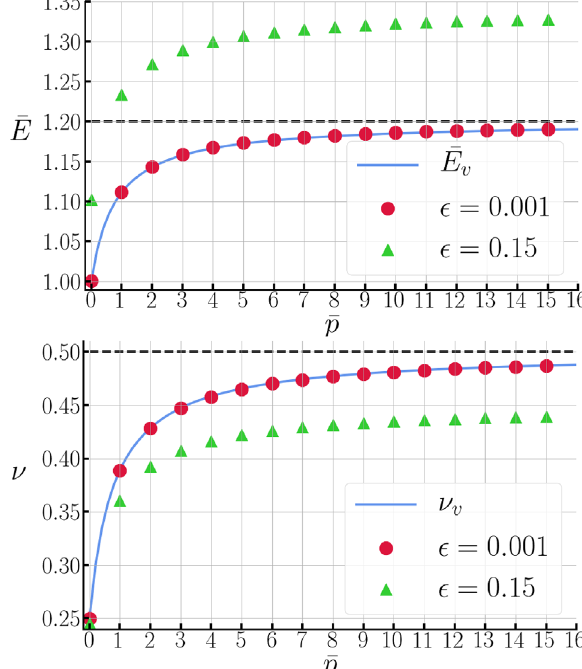
FIG. 15. (Top) Young ’ s modulus and (bottom) Poisson ’ s ratio of the MSM at small strain ϵ ¼ 0 . 1% and large strain ϵ ¼ 15% as a function of dimensionless volumetric pressure ¯ p ¼ p=E . is the dimensionless Young ’ s modulus which is equal to E =E . E is from Eq. (11), and ν v v